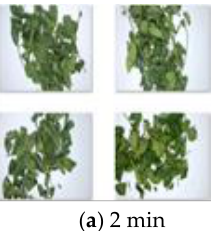
Figure 10. Training samples with different fixation time.